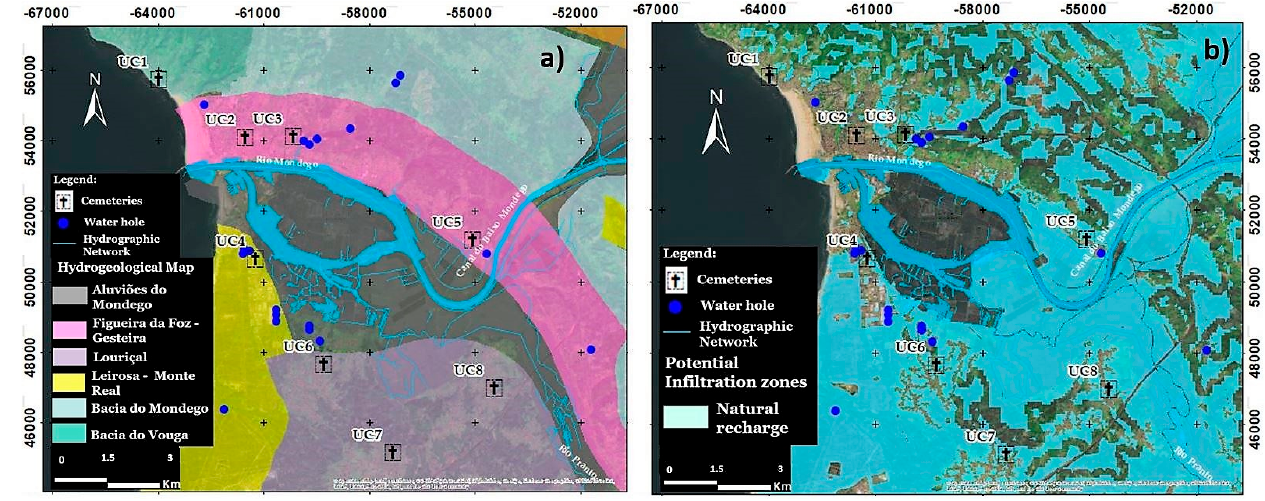
Figure 5. ( a ) Hydrogeological map; ( b ) potential infiltration zones of the studied area.